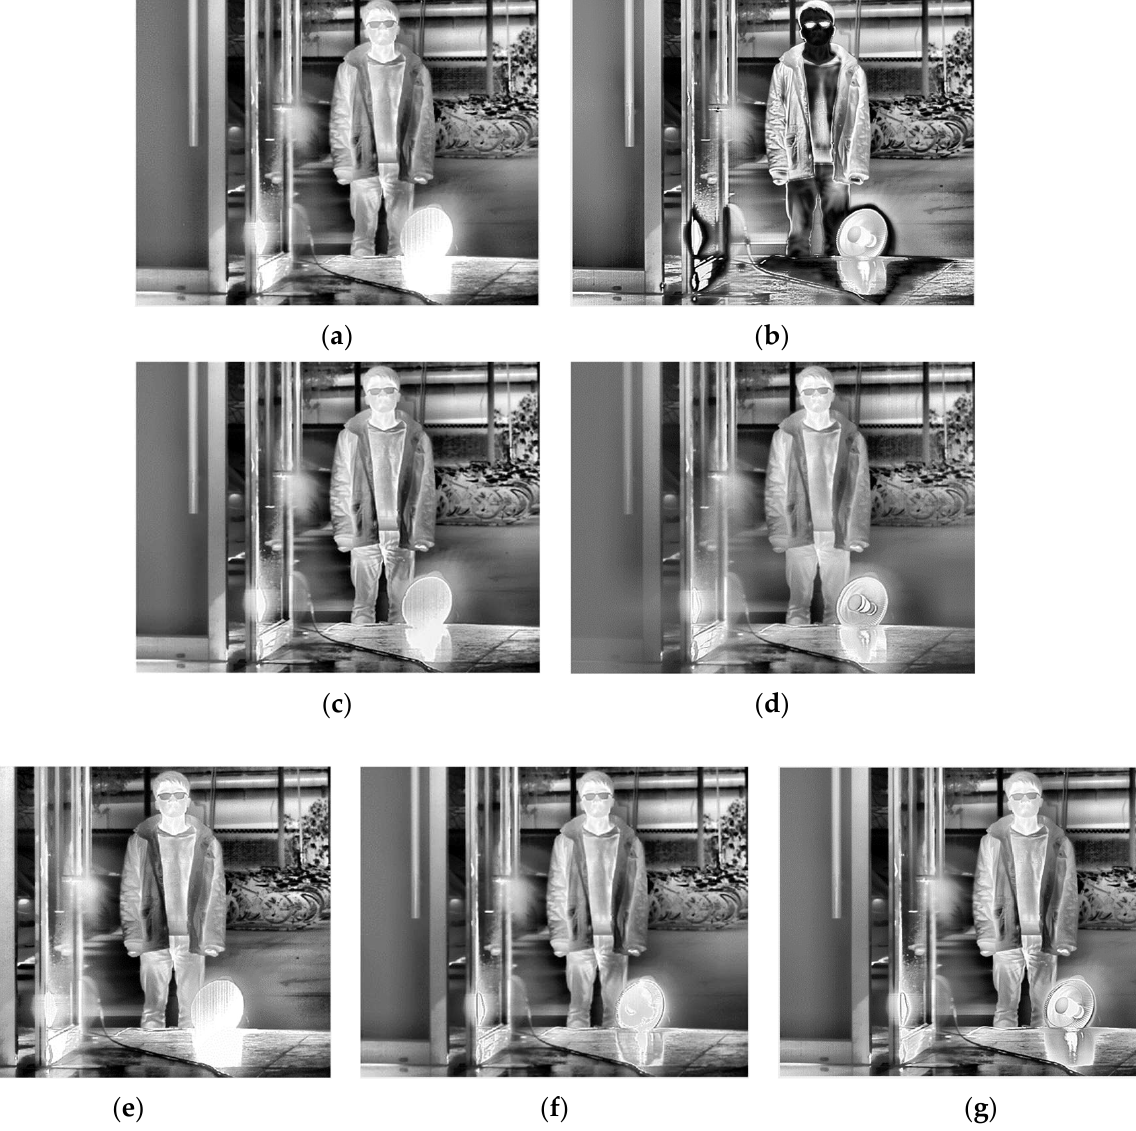
Figure 15. HDR fusion results for scene 3 with different selection methods: ( a ) single integration time (1995 μs); ( b ) ES; ( c ) EI; ( d ) MGD; ( e ) MW&EN; ( f ) ME; ( g ) proposed.